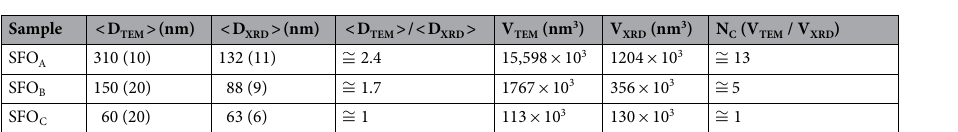
Figure 3. Bright field TEM images of ( a ) SFO A , ( b ) SFO B and ( c ) SFO C showing that they are composed of particles having a platelet shape. The corresponding size distributions are shown in the histograms of panels ( d – f ) respectively.